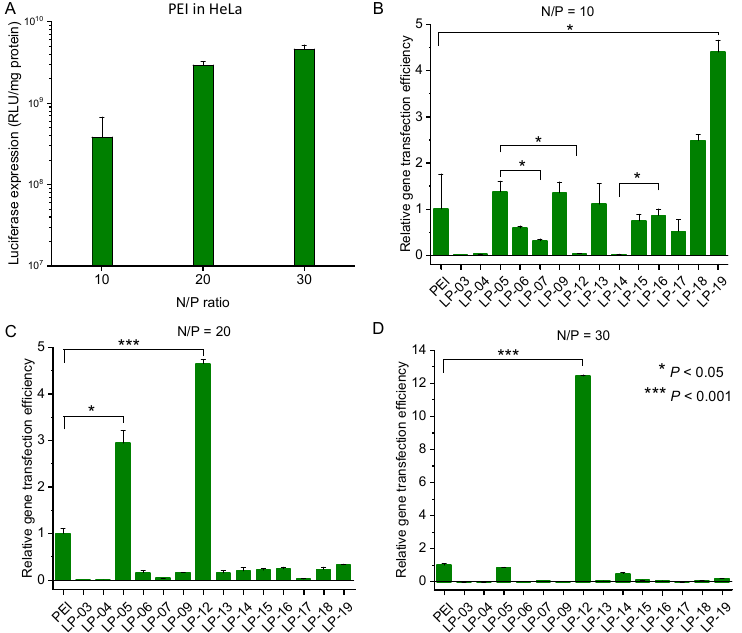
Figure 9. In vitro gene transfection efficiency of the complexes of PEI/pDNA in HeLa cells in the presence of serum at different N/P ratios ( A ). Relative gene transfection efficiency of the complexes of LP/pDNA in HeLa cell line in the presence of serum at N/P of 10 ( B ), 20 ( C ) and 30 ( D ). Data represent mean ± standard deviation (* p < 0.05, *** p < 0.001, n = 2). In the cell line of COS 7 (Figure 10), the copolymer LP-12 exhibited the best gene transfection capability among all the copolymers, which was ca. two to four times as high as that of standard PEI at the N/P ratios from 10 to 30.